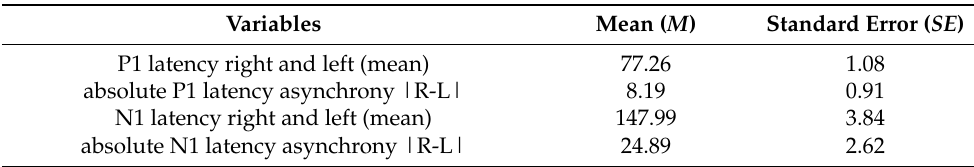
Table 4. Descriptive statistics of the four MEG